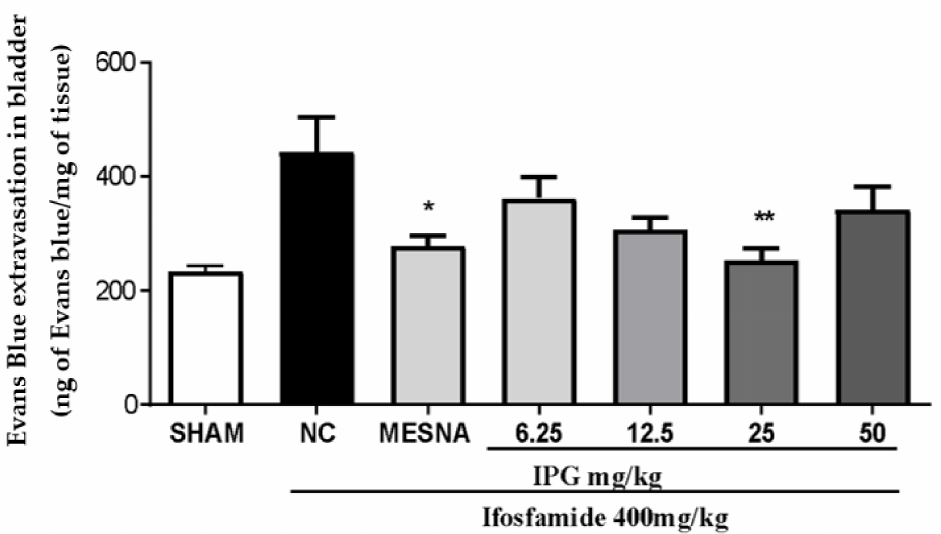
Figure 6. Effect of IPG on vascular leakage of Evans blue (EB) in bladders of animals with ifosfamide- induced hemorrhagic cystitis. Data are expressed in ng of Evans blue per mg of bladder as mean ± SEM ( n = 6). Data were compared with the negative control (Tween/saline), by one-way analysis of variance (ANOVA), followed by the Bonferroni test; * p < 0.05, ** p <